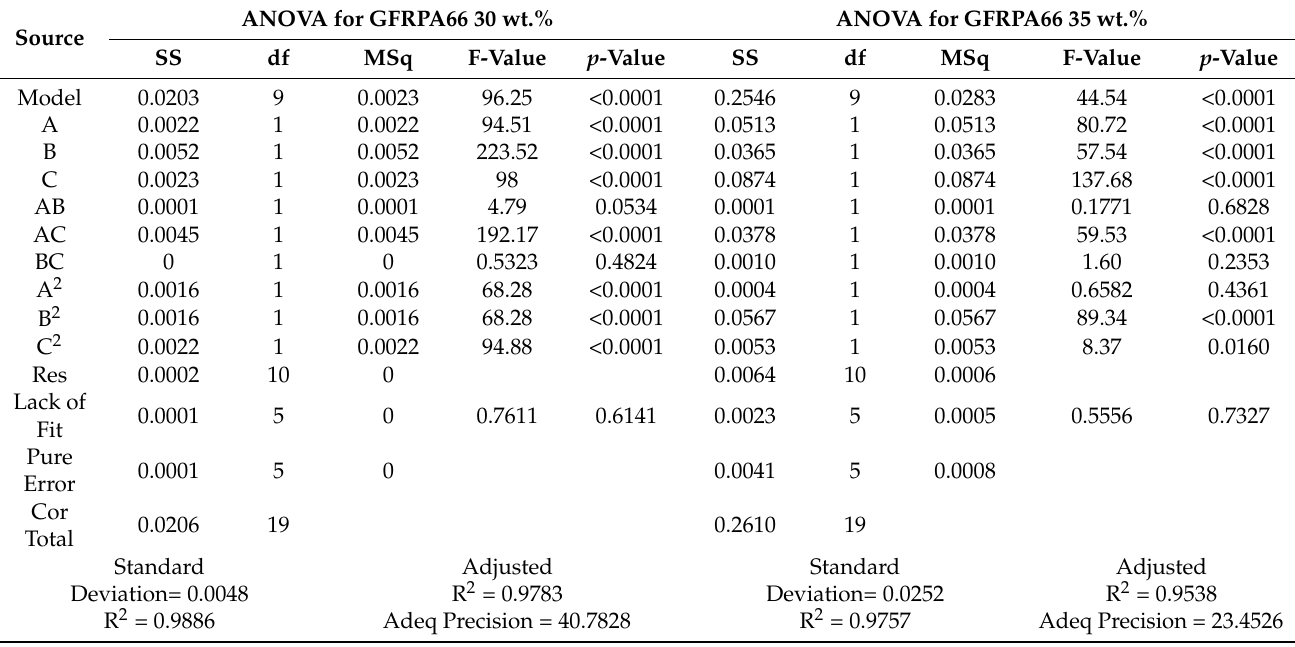
Table 2. ANOVA table of COF for GFRPA66 30 wt.% and GFRPA66 35